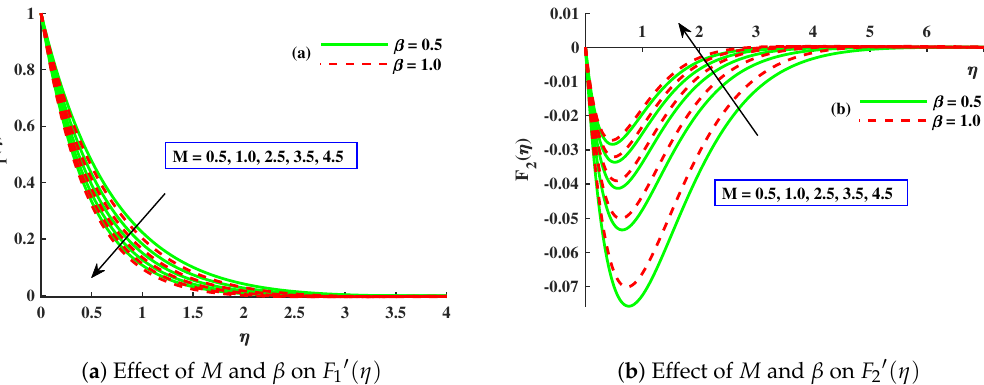
Figure 3. Curves of F 1 (cid:48) ( η ) andF 2 ( η ) along magnetic parameter ( M ) and boundary concentration parameter( β